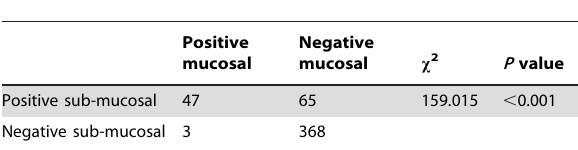
Table 2. Comparison of the positive proximal mucosal margin between positive proximal submucosal group and negative proximal submucosal